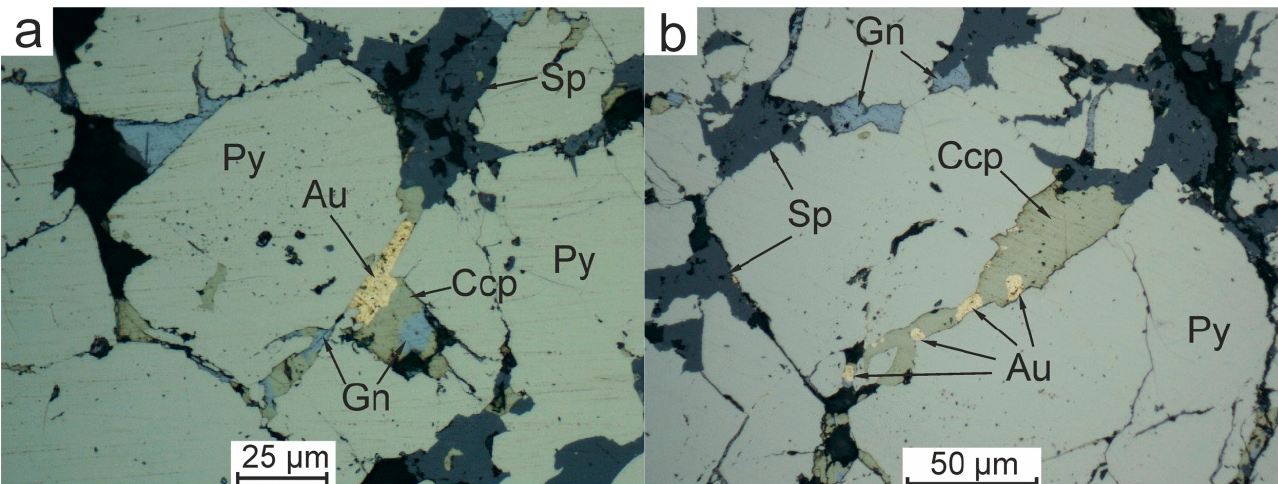
Figure 22. Solid Cu-Zn VMS ore with the late Au-polymetallic assamblege overprinted on the recrystallised early pyrite and native gold (Au) occurred in its interstices, the Novo-Uchaly lode, the Uchaly field: ( a ) Au + galena (Gn) + chalcopyrite (Ccp) + sphalerite (Sp), ( b ) Au + chalcopyrite + sphalerite.